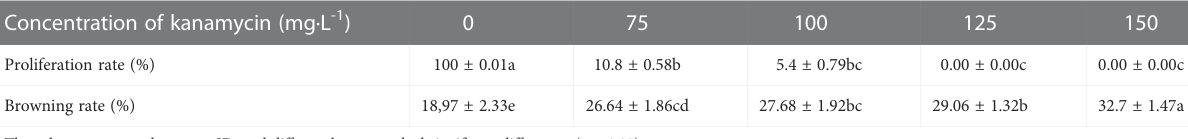
TABLE 3 Kanamycin effects on P. lacti fl ora callus proliferation.